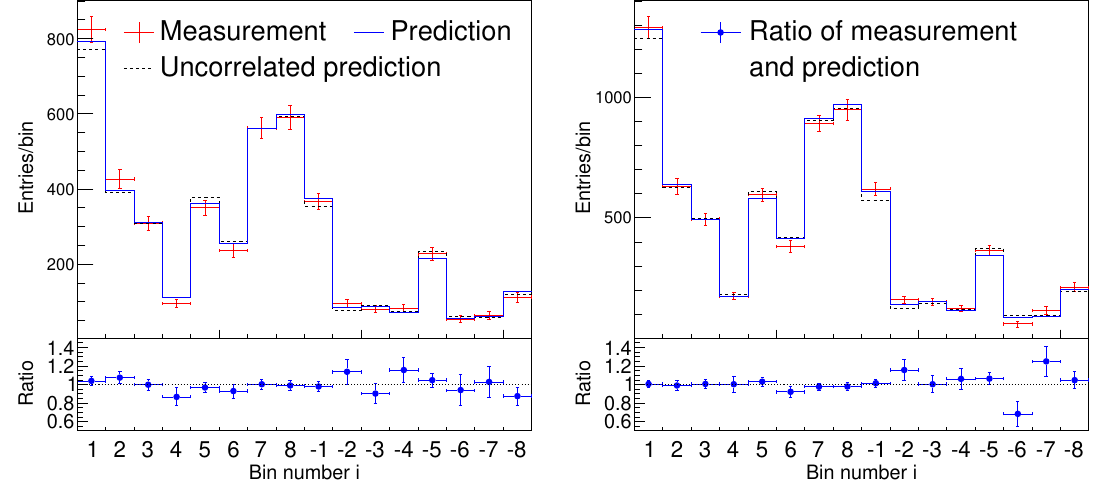
(left) and Y Kππ 0 (right) observables, with the predictions from the fit to all Figure 8 . The Y K 3 π i i the BESIII inputs. Also shown are the expectations from the uncorrelated